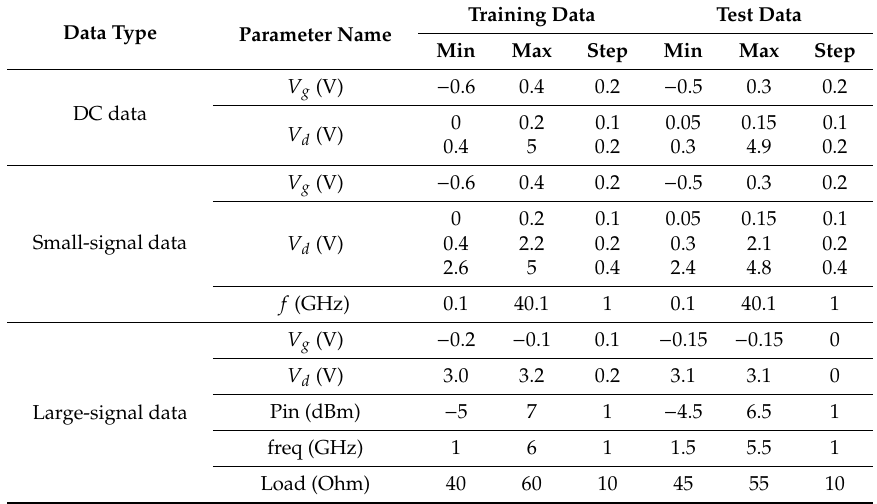
Table 2. Training data and test data for GaAs metal-semiconductor-field-e ff ect transistor (MESFET).